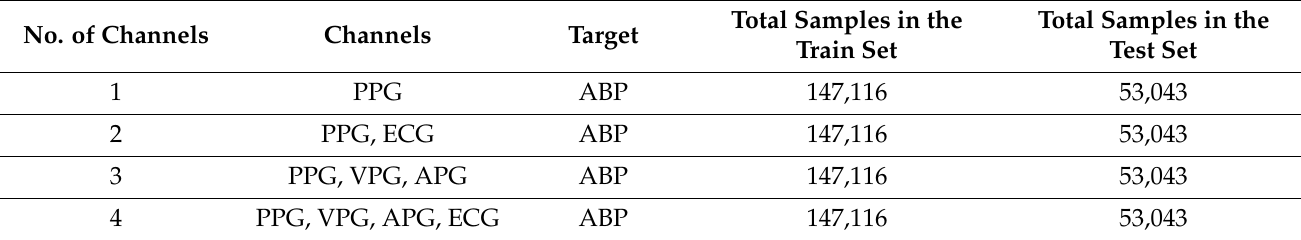
Table 2. Description of training and testing sets for Experiment